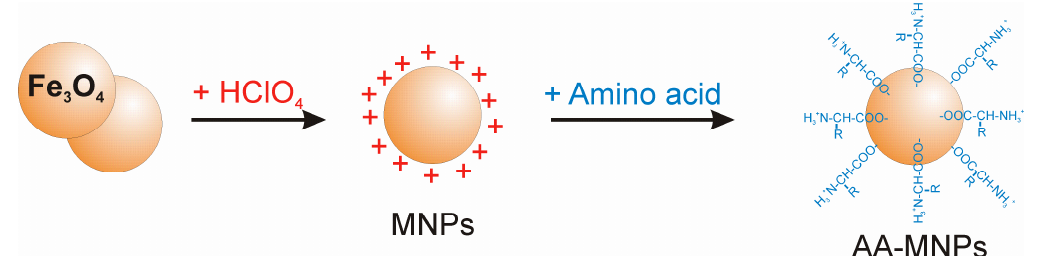
Figure 1. The scheme of magnetic nanoparticle (MNP) functionalisation by amino acids (AAs).